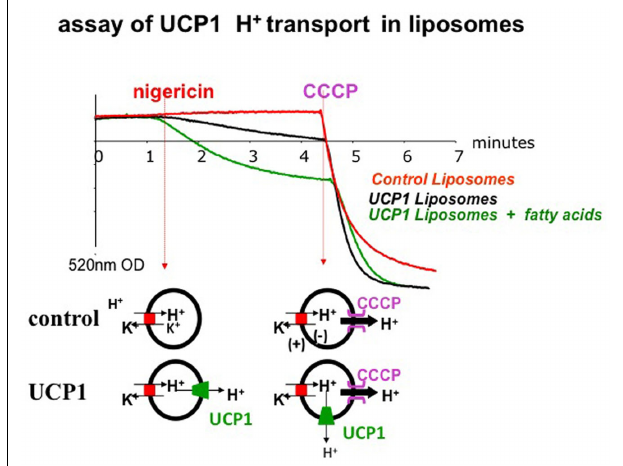
FIGURE 3 | Reconstitution of the proton transport activity of purified UCP1 in liposomes (Mozo et al., 2006). Membrane potential ( ΔΨ ) is appreciated using a safranin probe sensitive to membrane potential and allowing a measurement of optical density at 520nm. In presence of nigericin, H + is exchanged against K + (H + in, K + out), there is no charge exchange but a Δ pH is generated. In liposomes containing UCP1, UCP1 dissipates this Δ pH gradient and also increases ΔΨ inducing the polarization of the membrane (and a decrease of O.D. signal).The slope of the decrease of the safranin signal is an assay of UCP1 protonophoric activity. Addition of fatty acids to liposome containing UCP1 markedly polarizes the membrane due to activation of the protonophoric activity of UCP1. Upon addition of CCCP, a strong protonophor, H + ions go out and positively polarize the liposome membrane on external